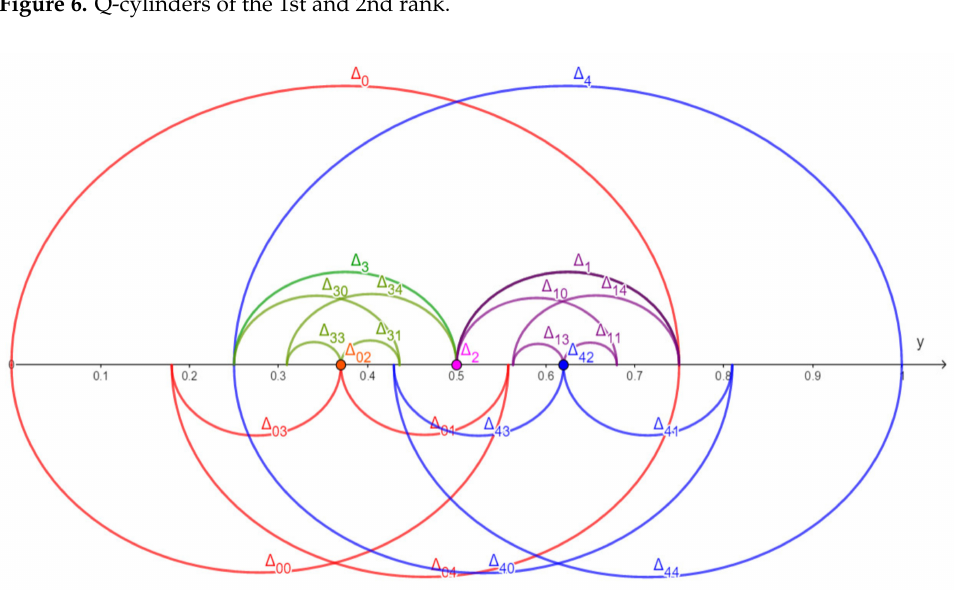
Figure 7. G-cylinders of the 1st and 2nd